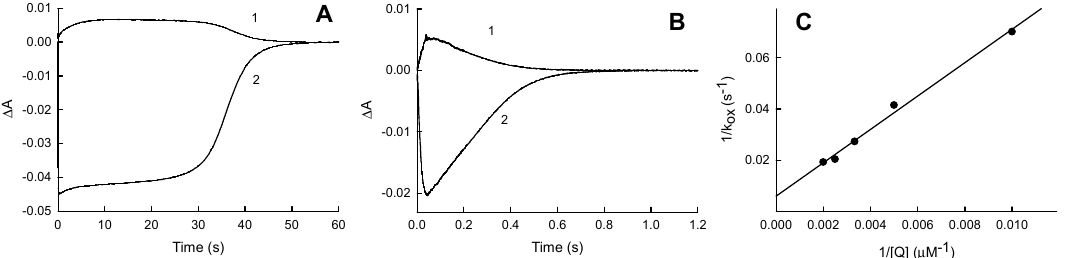
Figure 5. Turnover of PfFNR in the presence of NADPH and oxidants. ( A , B ) The kinetics of the absorbance changes at 600 nm (1) and 460 nm (2) during the reduction of Pf FNR (6.0 µ M) by 50- µ M NADPH and its subsequent reoxidation by oxygen ( A ) or 250- µ M tetramethyl-1,4-benzoquinone ( B ) (concentrations after mixing). ( C ) The dependence of an apparent first-order reoxidation rate constant on the concentration of tetramethyl-1,4-benzoquinone.